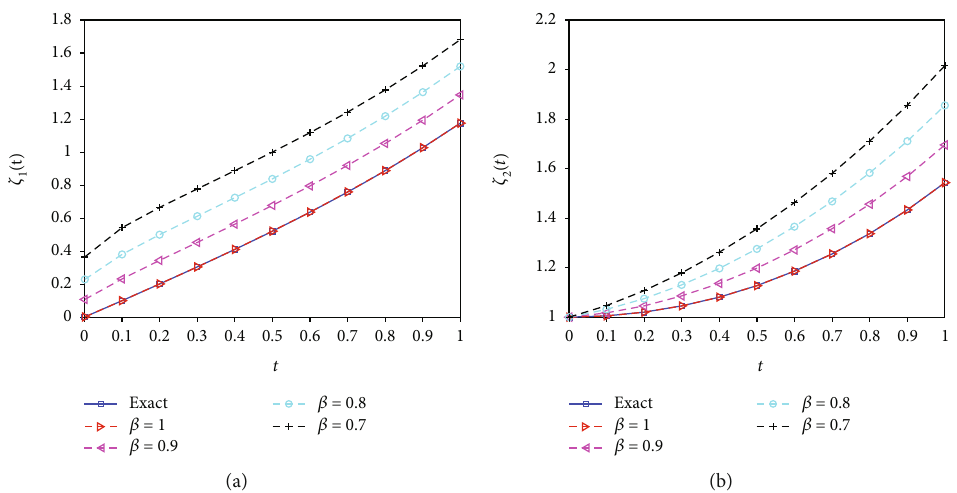
Figure 9: In (a), the numerical solutions corresponding to Problem 5 for fractional-order β for ζ solutions corresponding to Problem 5 for fractional-order β for ζ